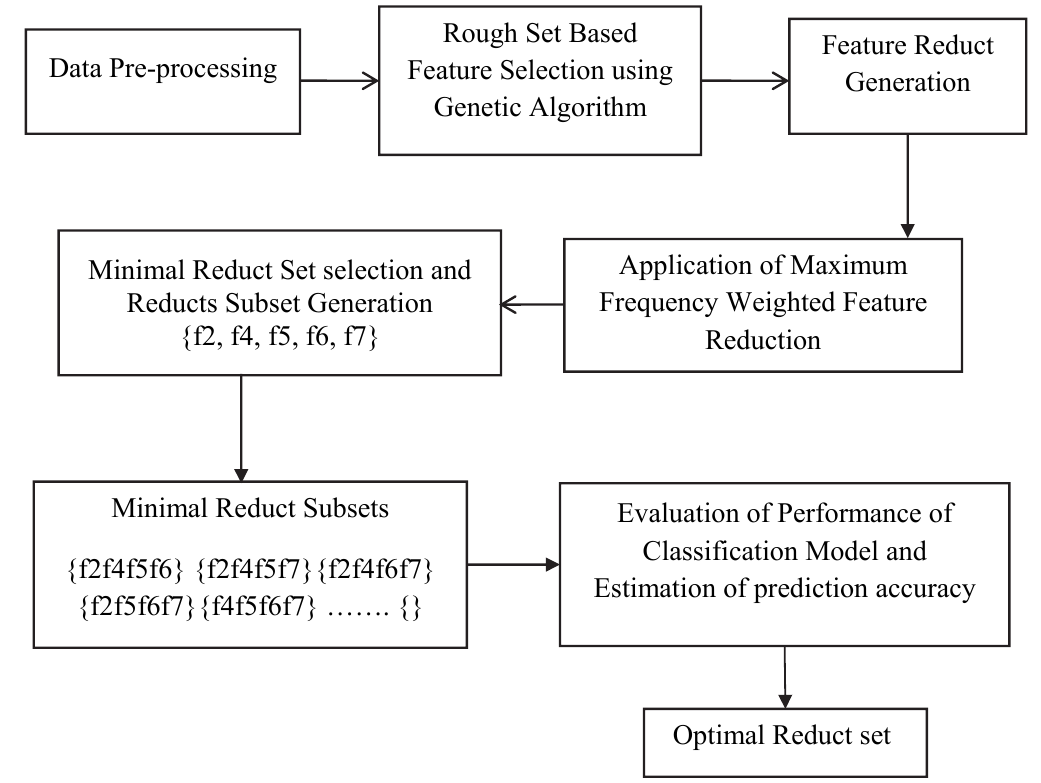
Fig. 2. Rough Set based optimal Parameter Selection